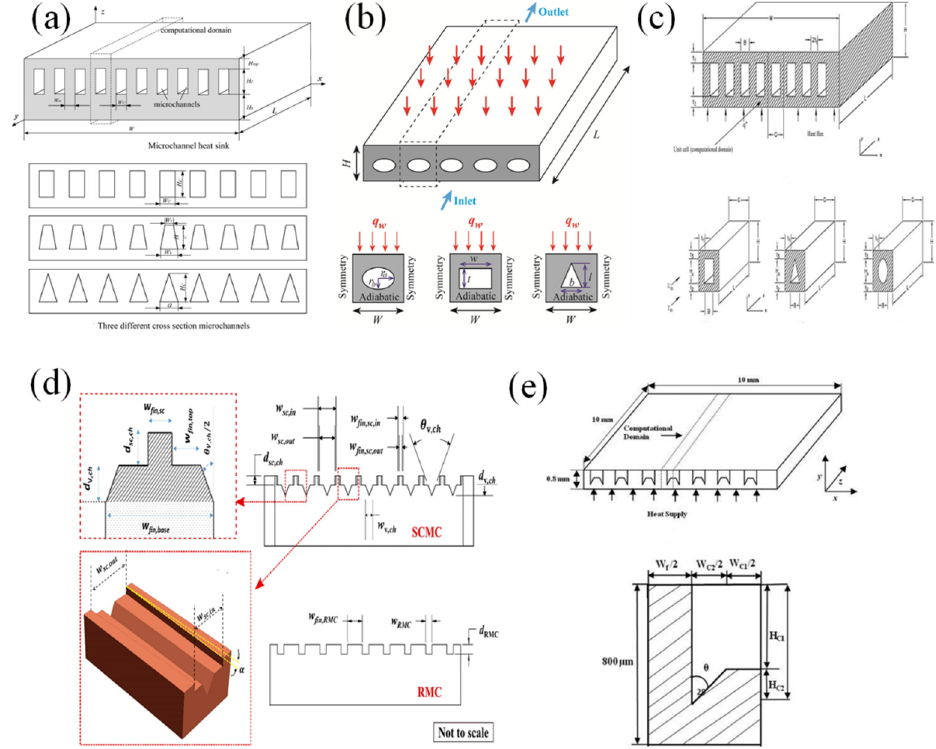
Figure 5. Schematic diagram of various geometric cross-section microchannels: ( a ) Wang et al. (adapted from Ref. [57]); ( b ) Jing et al. (adapted from Ref. [58]), ( c ) Salimpour et al. (adapted from Ref. [59]), ( d ) Raj et al. (adapted from Ref. [64]), ( e ) Khan et al. (adapted from Ref. [65]).